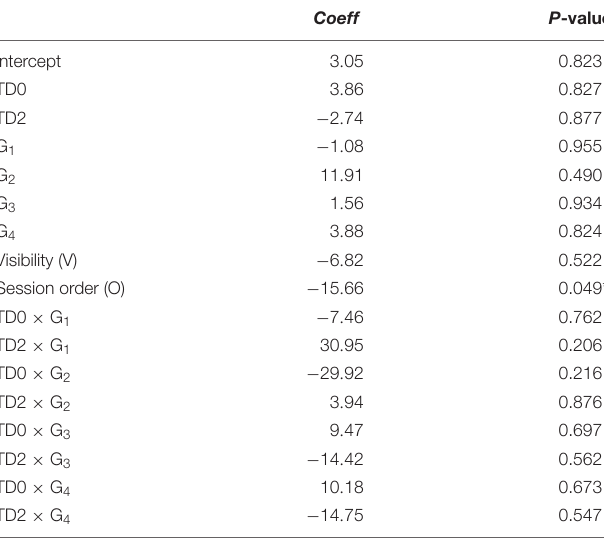
TABLE 6 | Interval between the instant in which hitter arrived in intersection point TABLE 8 | Effect of “catch trials” on interval between the instant in which hitter and the maximum speed time. arrived in intersection point and the maximum speed time. Coeff P -value Coeff P -value